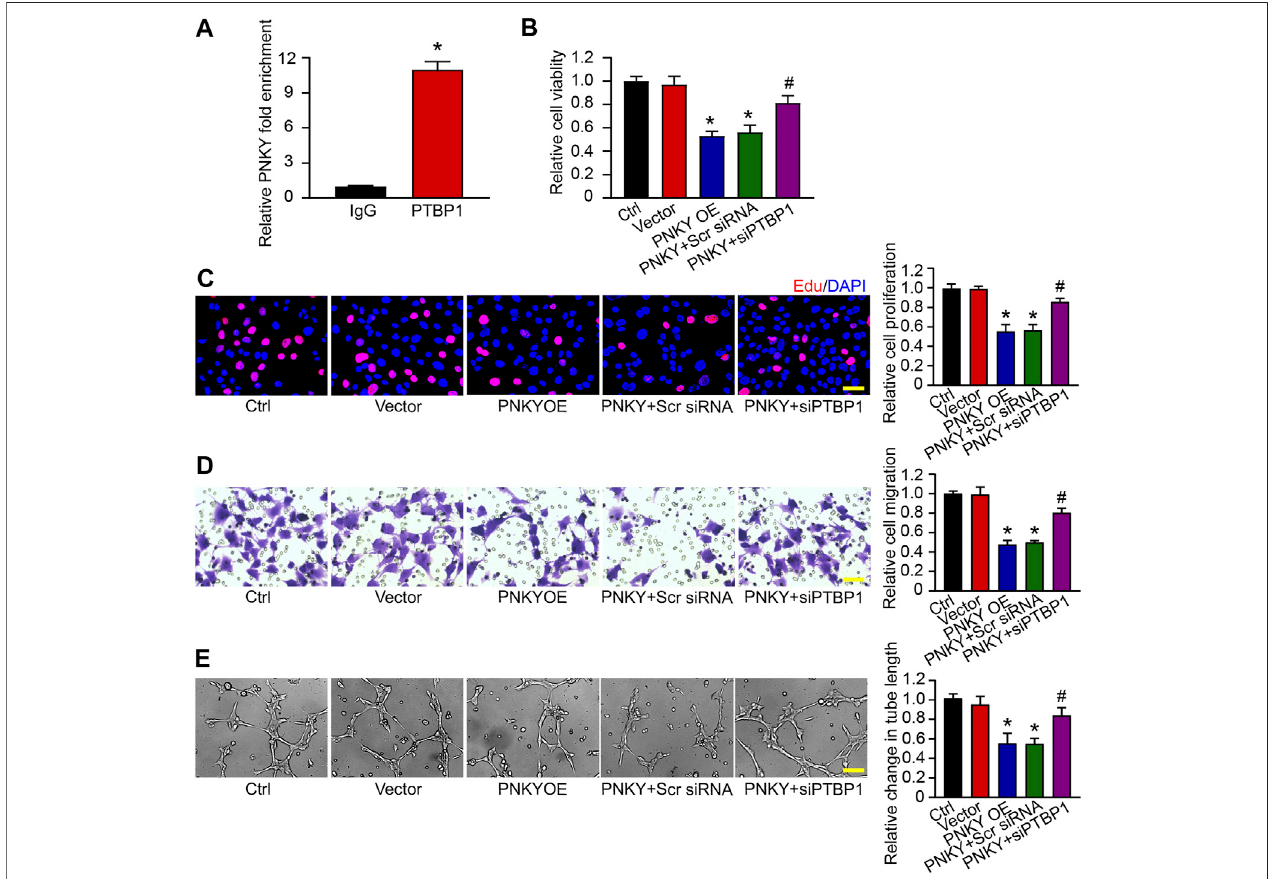
FIGURE 5 | LncRNA PNKY functions biologically by binding to PTBP1. (A) PTBP1 antibody was incubated with RF/6A cell extracts and qRT-PCR was performed to test the relative fold enrichment of PNKY associated with PTBP1. Normalized to the negative IgG control ( n = 4, * p < 0.05 versus IgG, Mann – Whitney U test). RF/6A cellsweretransfectedwithpcDNA3.0vector(Vector),pcDNA3.0-PNKY,pcDNA3.0-PNKYplusscrambled(Scr)siRNA,pcDNA3.0-PNKYplusPTBP1siRNA(siPTBP1), or left untreated (Ctrl) for 24 h. (B) Cell viability was detected using MTT method ( n = 4, * p < 0.05 versus Vector, # p < 0.05 versus PNKY OE, one-way ANOVA followed by Bonferroni ’ s post hoc test). (C) Cell proliferation was detected using EdU staining and quanti fi ed. Blue: DAPI; red: EdU (Scale bar, 50 μ m, n = 4, * p < 0.05 versus Vector, # p < 0.05 versus PNKY OE, one-way ANOVA followed by Bonferroni ’ s post hoc test). (D) The migration of RF/6A cells was detected using Transwell assay and quanti fi ed (Scale bar, 50 μ m, n = 4, * p < 0.05 versus Vector, # p < 0.05 versus PNKY OE, one-way ANOVA followed by Bonferroni ’ s post hoc test). (E) The pictures of tube-shaped structures were captured 4 h after cells seeding on the matrix to analyze the average length of tube formation for each fi eld (Scale bar, 200 μ m, n = 4, * p < 0.05 versus Vector, # p < 0.05 versus PNKY OE, one-way ANOVA followed by Bonferroni ’ s post hoc test).